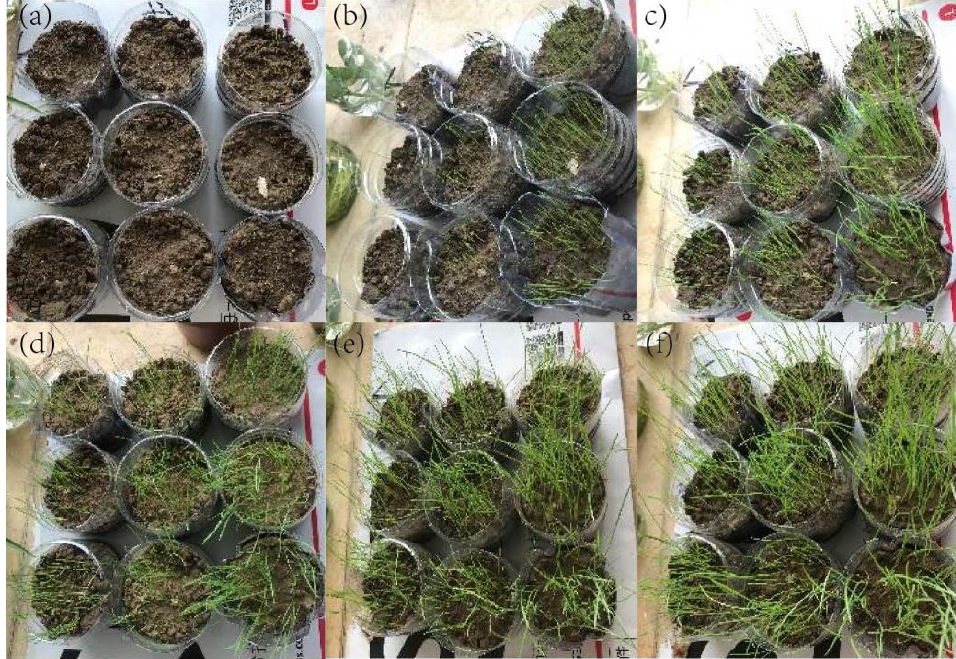
Figure 6. ( a – f ) Germination of plant seeds cultured with the optimal formula solution, the prelim- inary formula solution, and the pure water on days 1, 3, 5, 8, 10, and 12, respectively. Table 6. Relative damage rates of plant